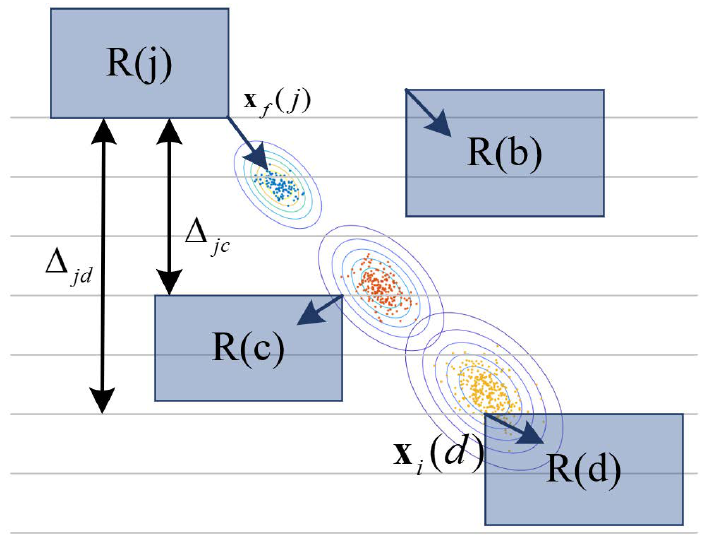
Figure A1. Gap penalty calculation using the linear robot motion